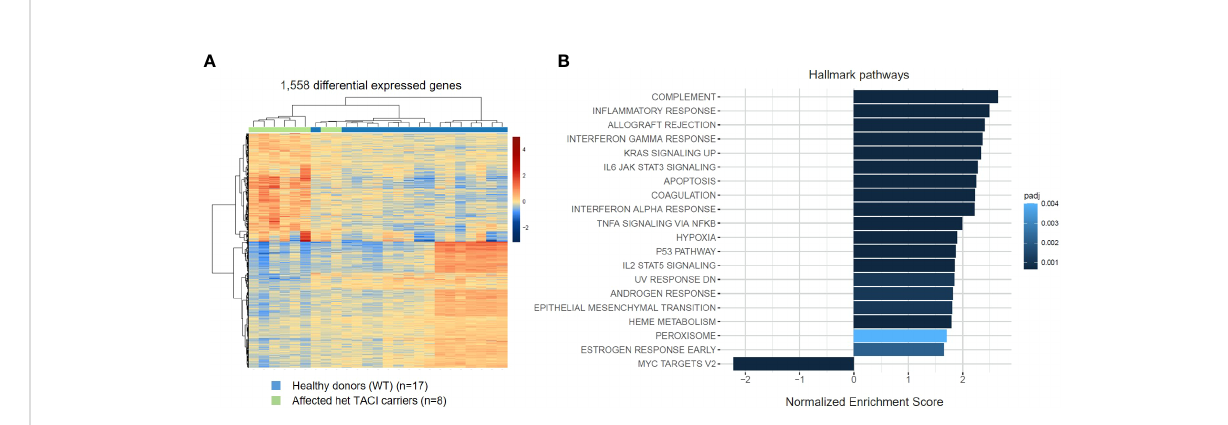
FIGURE 4 Transcriptome analysis of stimulated naïve B cells from TACI mutation carriers and healthy donors. (A) Heatmap of DEG on RNA level for stimulated naïve B cells from TACI mutation carriers and WT (log2 fold change >0.5) Red: upregulated genes; blue: downregulated genes. (B) Statistically over-represented Hallmark pathways associated with increased (right bars) or decreased (left bars) DEG depicted by the histogram.